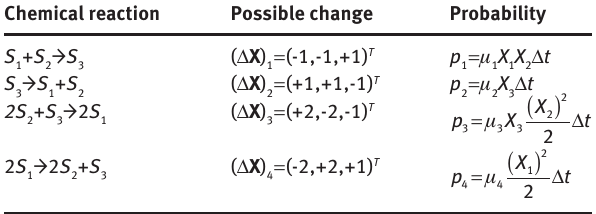
Table 1 Possible molecular population changes in Δ t and